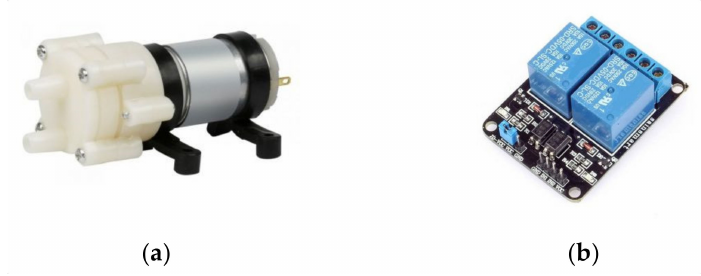
Figure 9. ( a ) Electric pump and; ( b ) Relay